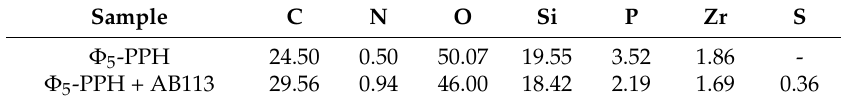
Table 3. Atomic concentration (%) of samples Φ 5 -PPH and Φ 5 -PPH + AB113 determined by